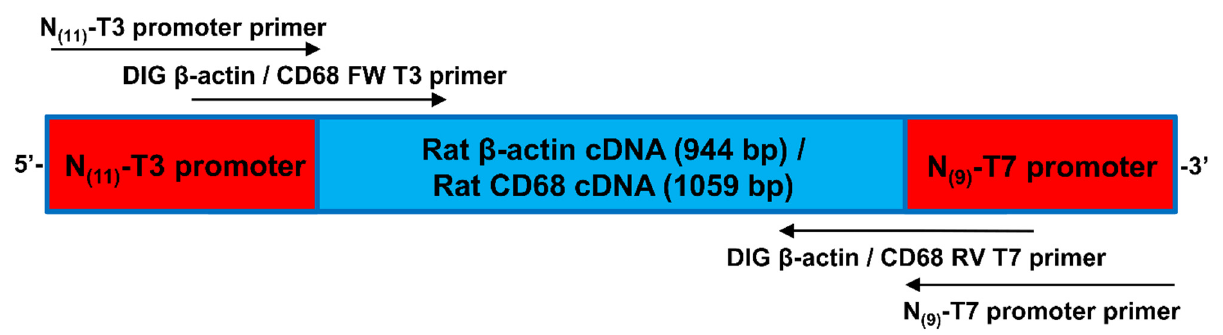
Figure 2. Schematic representation of the PCR product (together with primer localization and orientation) used for in vitro transcription.